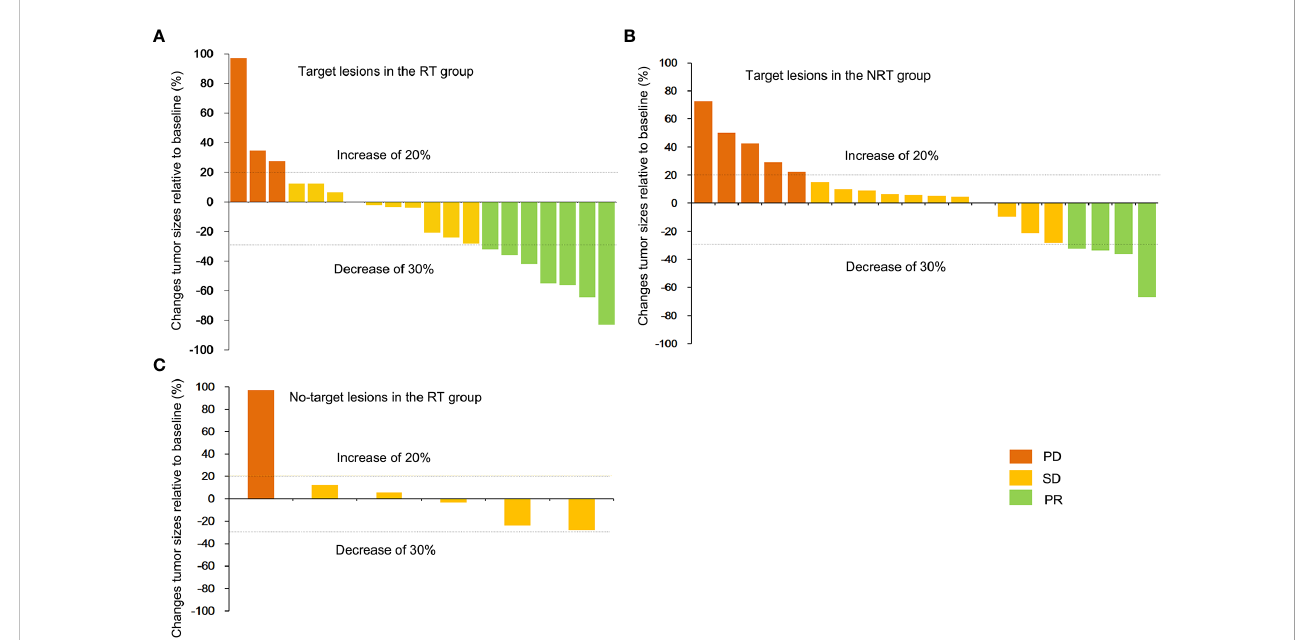
FIGURE 4 Best percentage change in the RT group. The best percentage change in the sum of the diameters of the target lesions from baseline (A) in the RT group and non-target lesions from baseline for nine patients in the RT group (C) . (B) shows the maximum percentage change in the sum of the diameters of the target lesions from baseline in the NRT group.